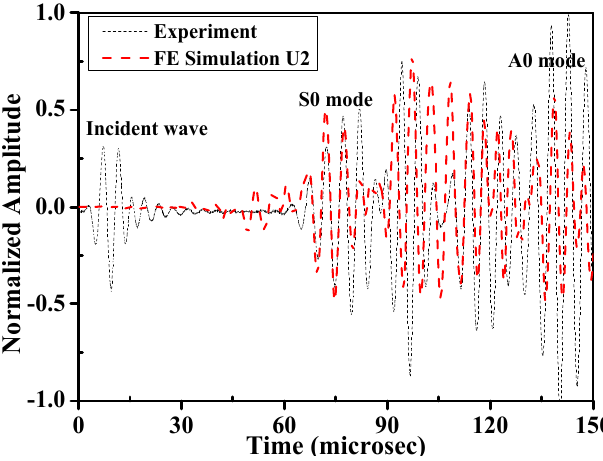
Figure 15. Comparison of the normalized amplitude between FE simulation and the experiments.